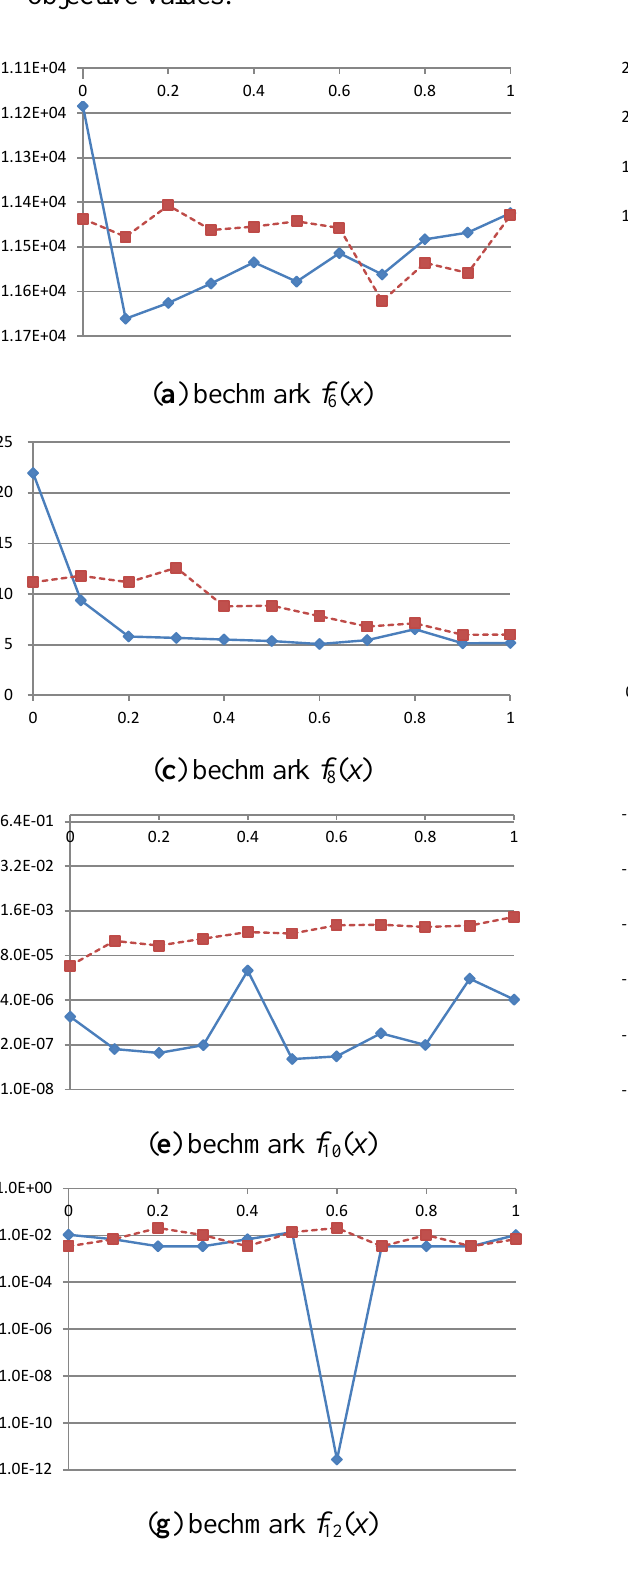
Figure 7. ICAAI (solid line) and ICACI (dashed line) for multimodal benchmark functions f ~ f . The horizontal axis is ρ, and the vertical axis is the average of the best 6 13 objective